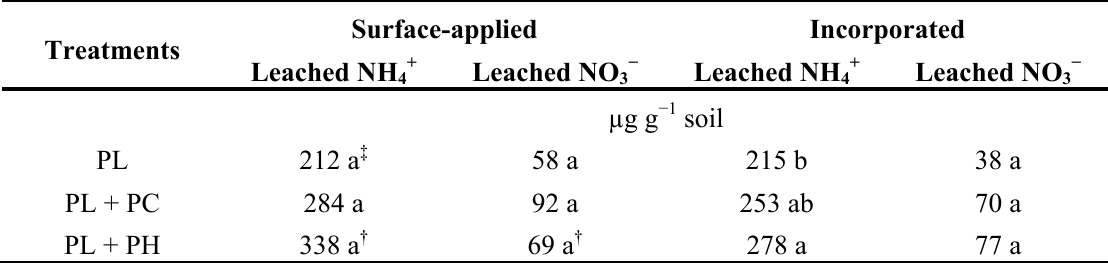
Legend for Table 4: PC and PH refer to biochar from pine chips and peanut hulls, respectively. ‡ Within each column, different letters (a,b) mean significant difference between treatments at 0.05 level of significance. † means one observation